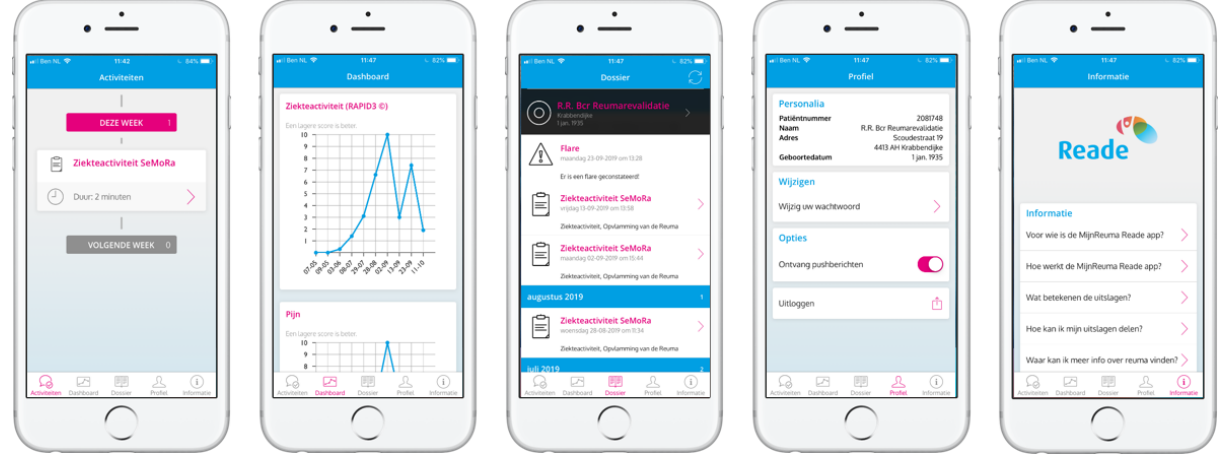
Figure 2. The MijnReuma Reade App. Five separate screenshots illustrate the simple and comprehensive design and interface of the app. The second screenshot from the left portrays one of the disease activity